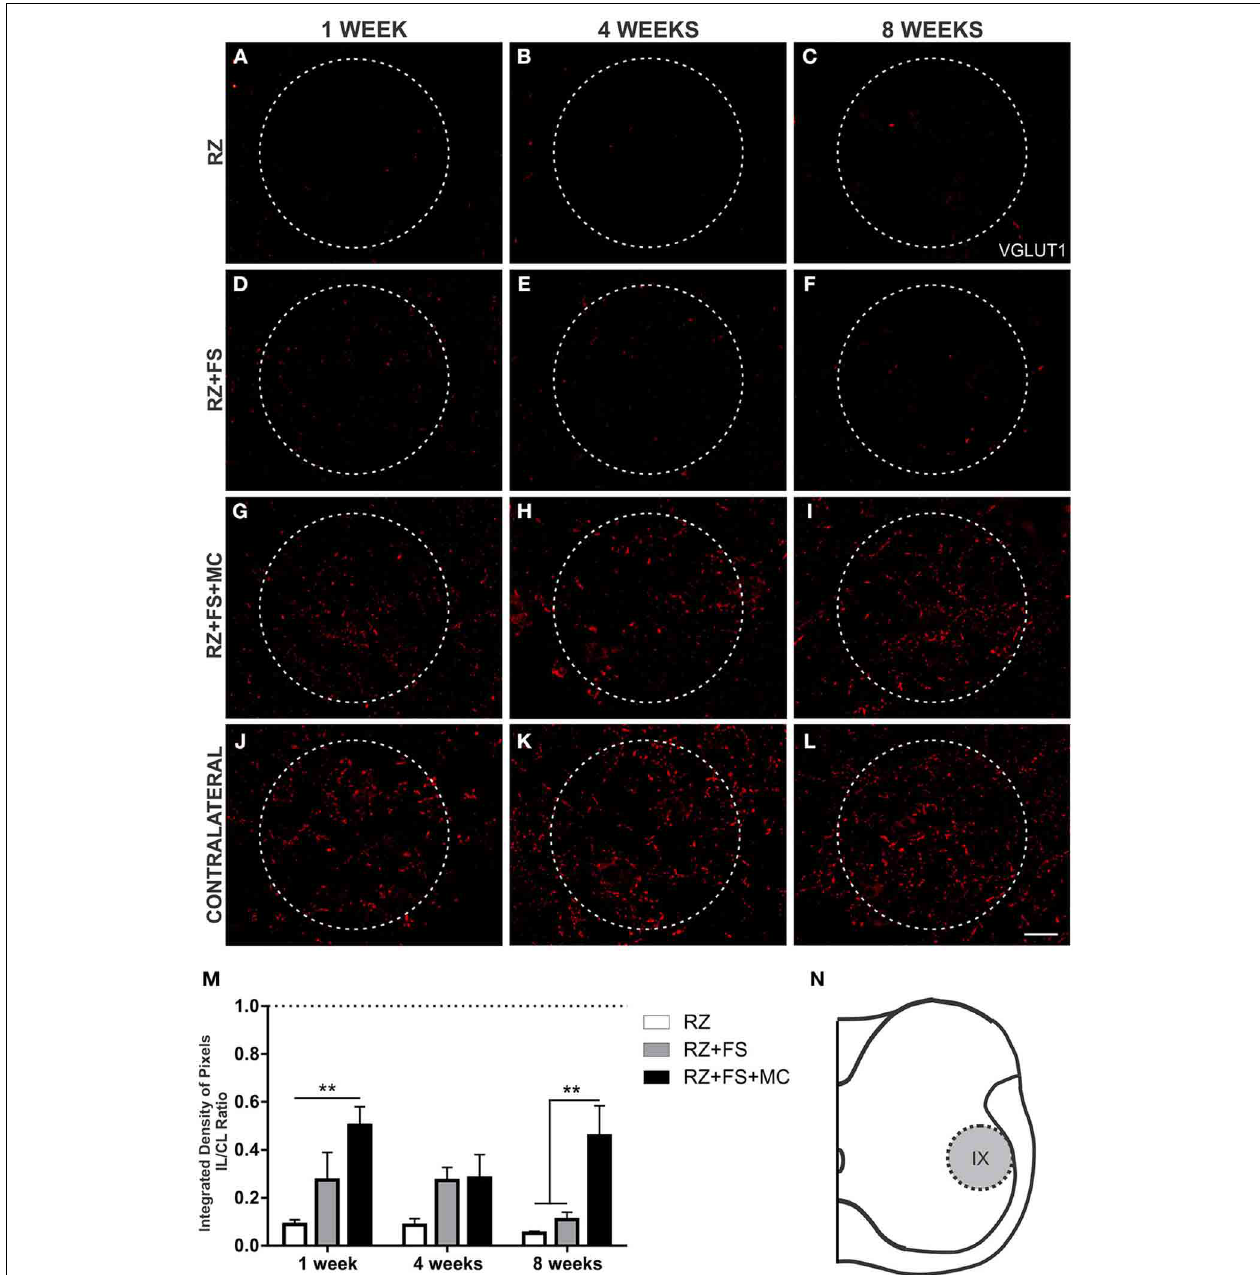
FIGURE 9 | Immunohistochemistry for vesicular glutamate transporter 1 (VGLUT1). (A–L) Representative images of RZ, RZ + FS and RZ + FS + MC, 1, 4, and 8 weeks post lesion. (M) Quantification (ratio IL/CL) of the integrated density of pixels, obtained in the